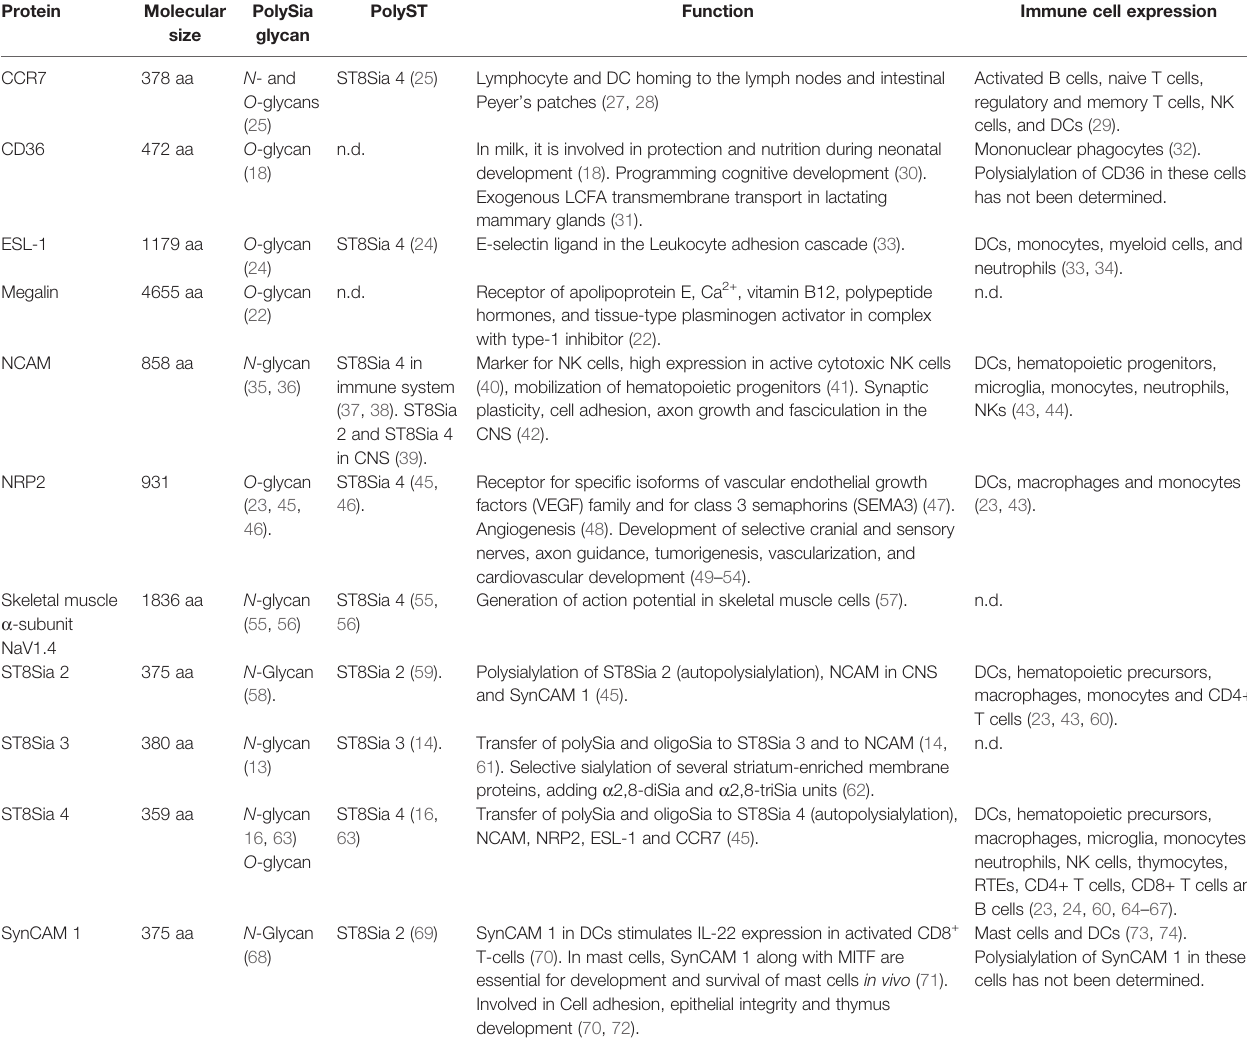
TABLE 1 | Mammalian polysialylated proteins. Protein Molecular